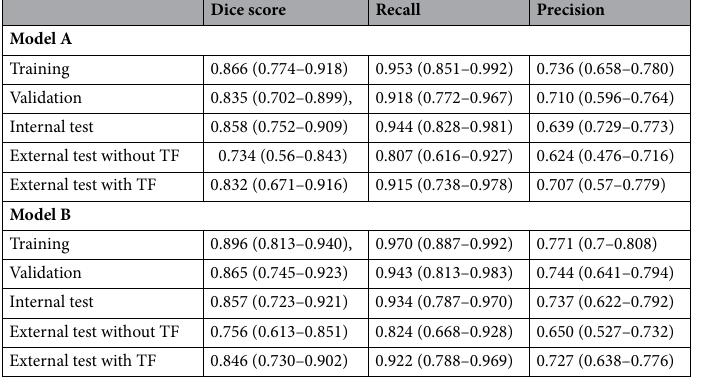
Table 2. Diagnostic performances of Models A and B. Continuous variables are presented with median and interquartile ranges. TF transfer